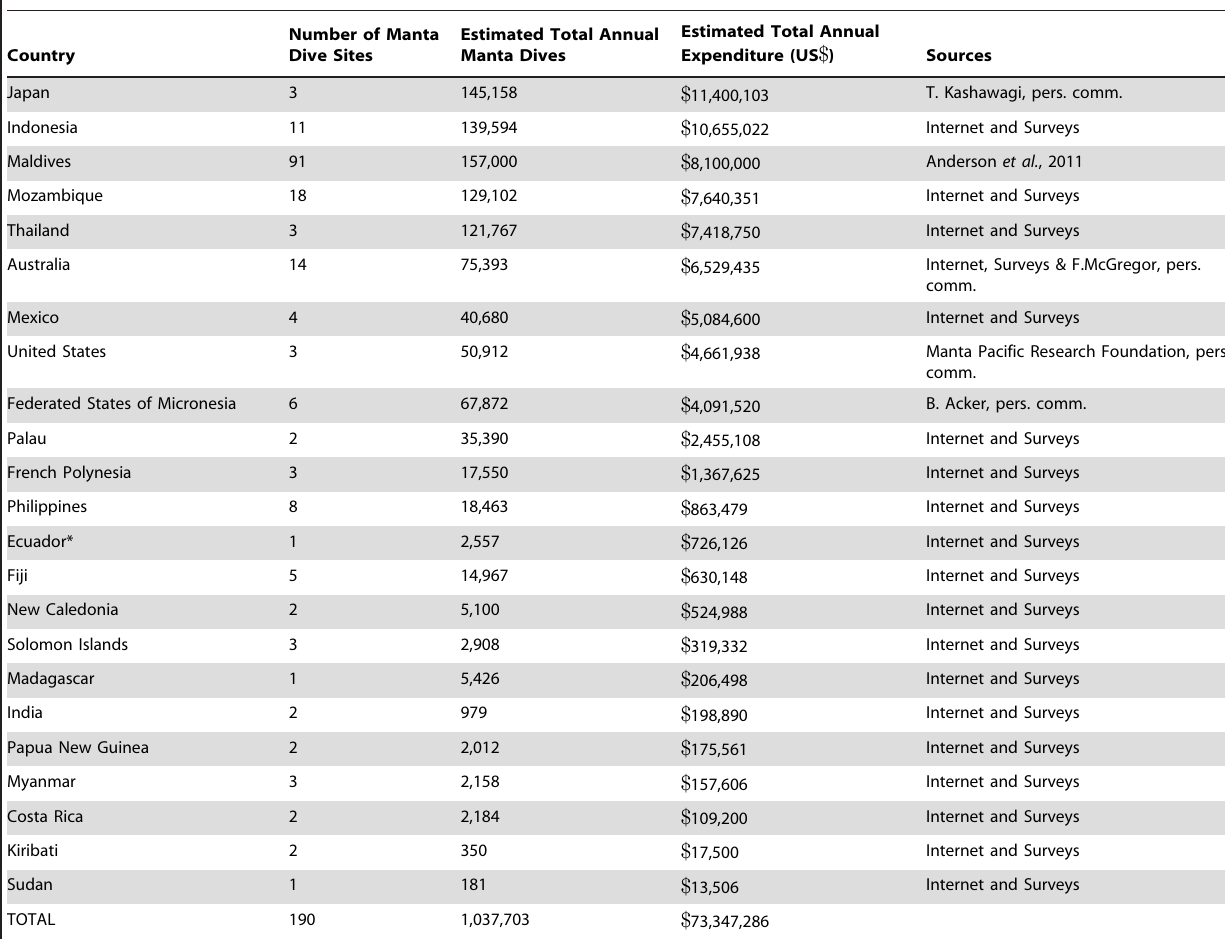
Table 2. Manta Ray Watching Tourism Extent and Dive Expenditure Estimates (US $